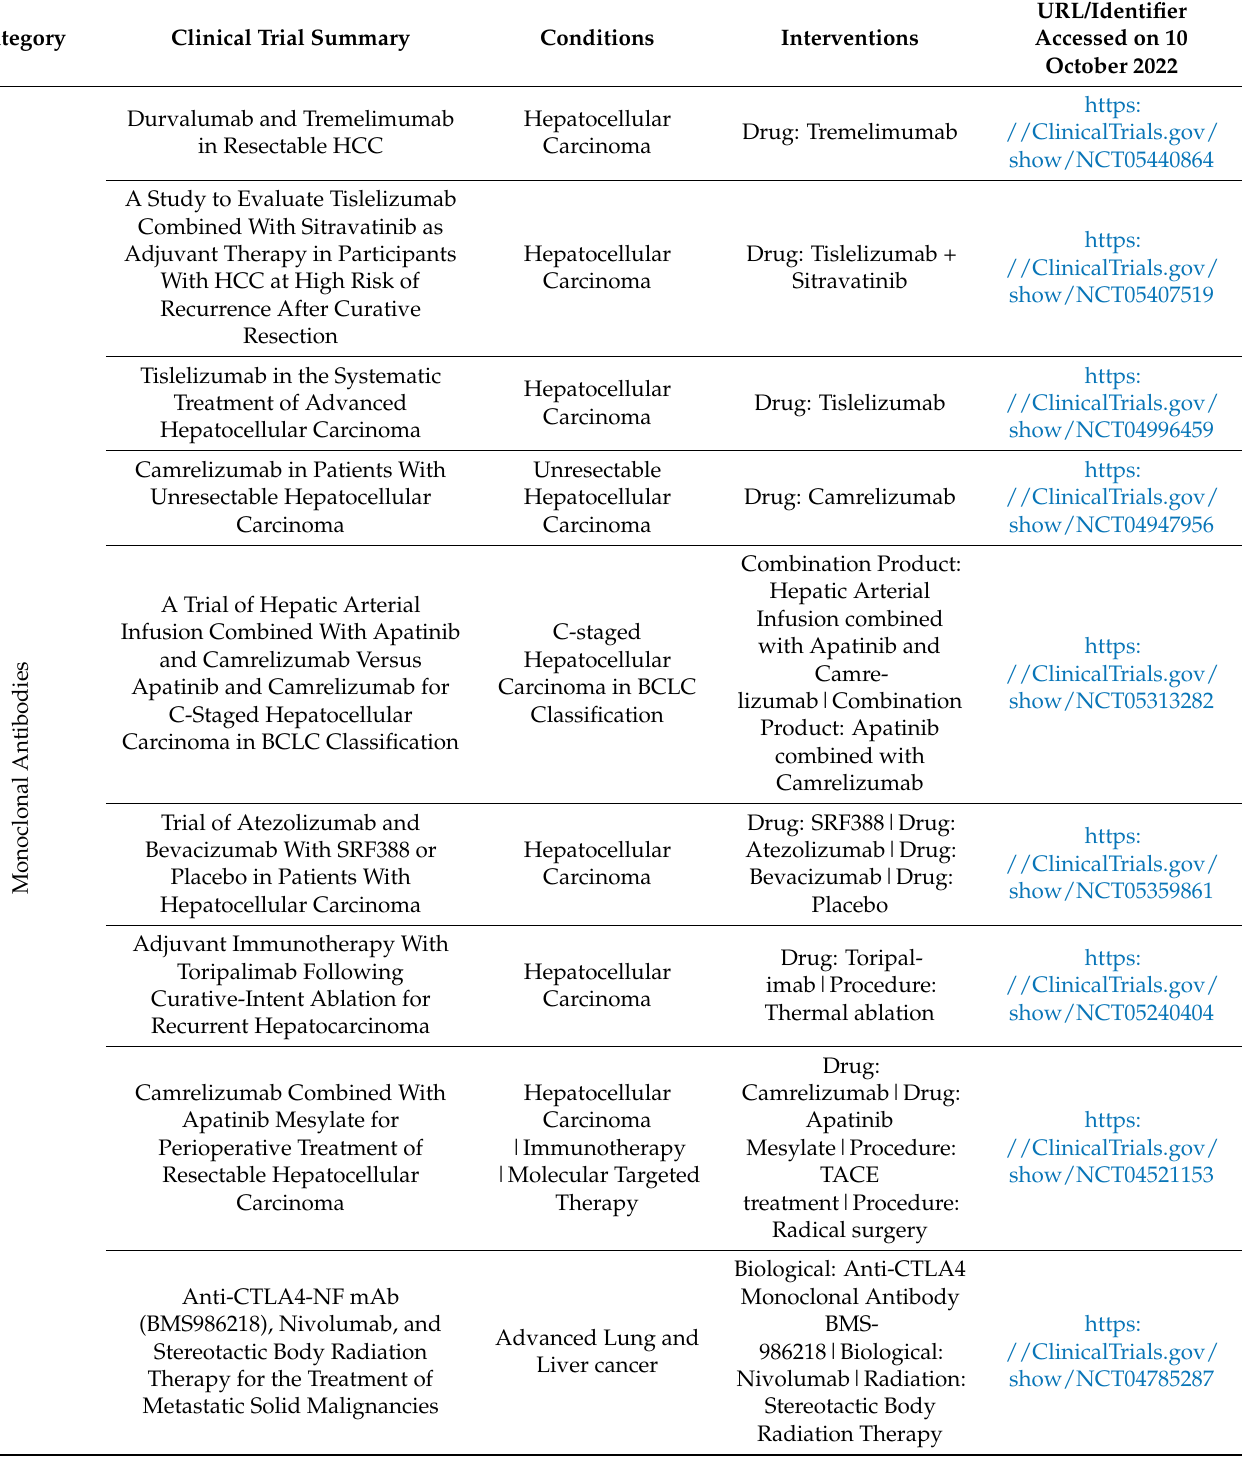
Table 1. List of innovative therapies for liver